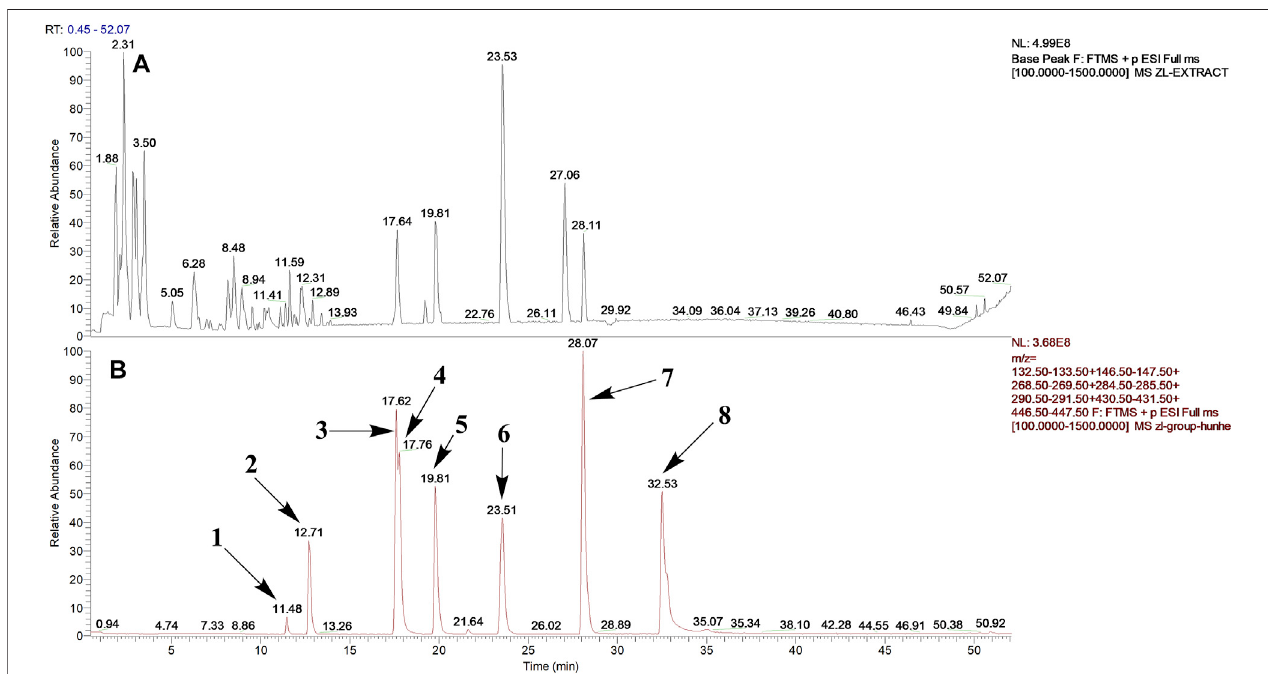
FIGURE1| RepresentativeUPLC-HRMS chromatogram ofZLHXTY capsule. (A) ChromatogramofZLHXTY capsuleinpositiveionmodeswithintherange ofm/z 150-1500 at a resolution of 70,000; (B) chromatogram of mixed chemical standards, L-epicatechin, calycosin-7-O- β -glucoside, coumarin, ononin, calycosin, cinnamaldehyde, formononetin, and